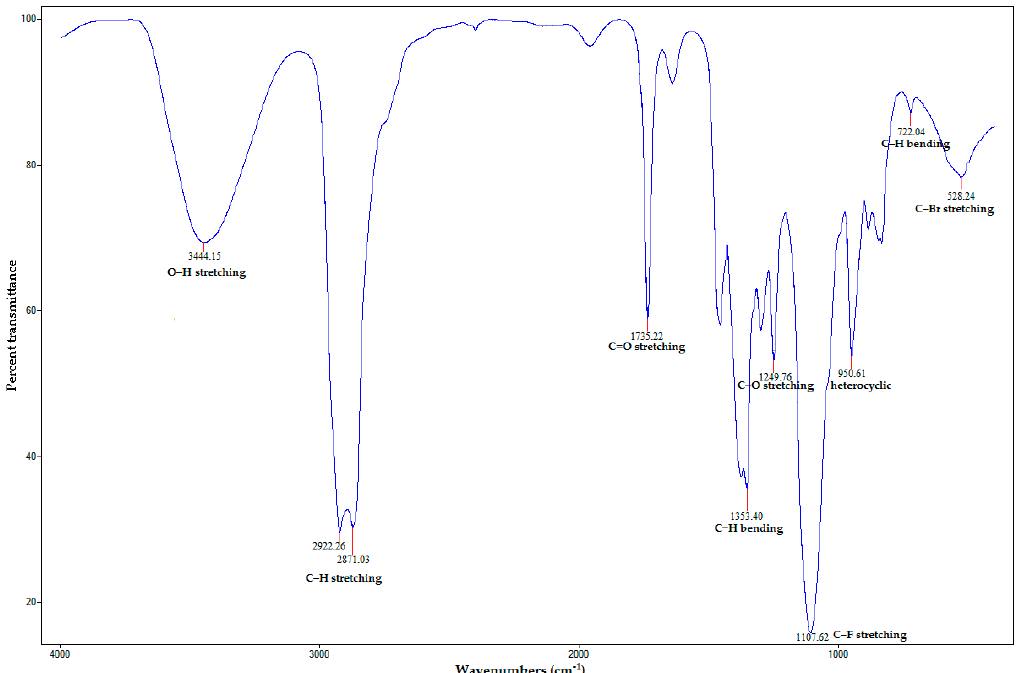
Figure 4. Fourier transform infrared (FTIR) absorption spectra of AgNPs synthesized using C. zedoaria oil (ZEO-AgNPs).